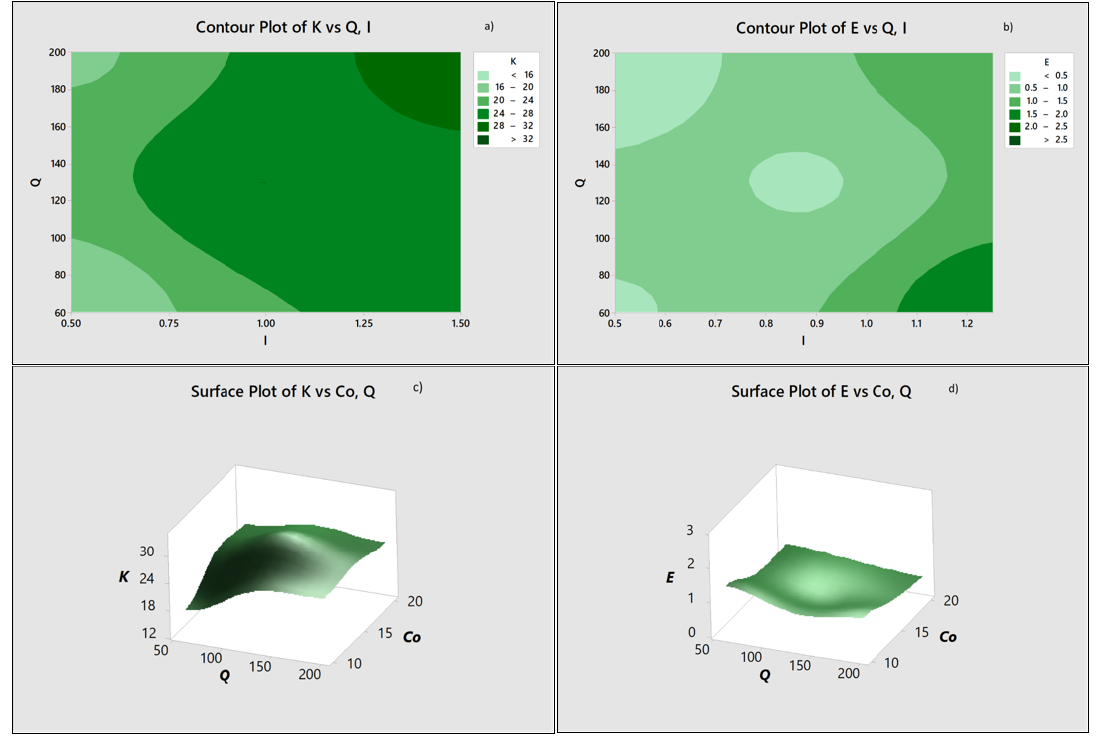
Figure 6. Contour plots and surface plots of K (panel ( a , c )) and E (panel ( b , d )), respectively. (I, Q, C 0 stand for applied current, electrolyte flow rate and initial concentration, respectively).